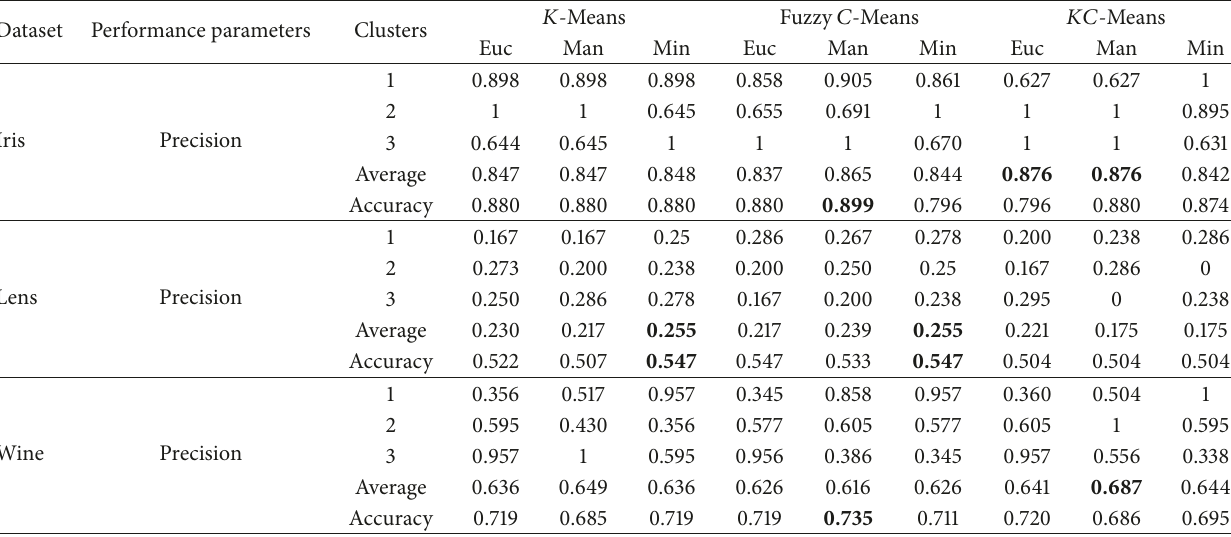
Table 2: Performance analysis of KM, CM, and KCM clustering techniques on data and benchmarks Iris, Lens, and Wine datasets. Note that each data has 3 clusters; the best precision and accuracy for each data set is in bold